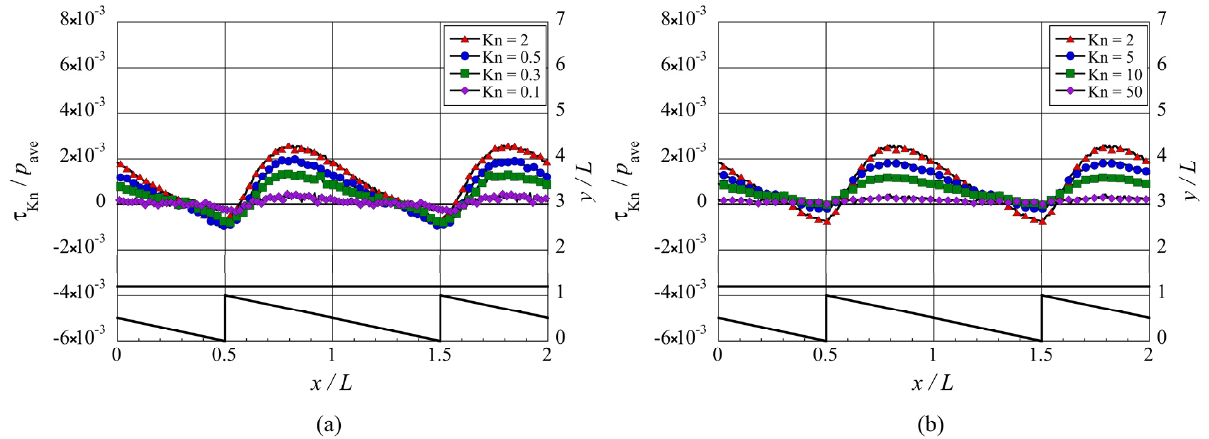
Figure 11. Distributions of the local tangential Knudsen stress, i.e., local propulsive force per unit area, for the ratchet microstructure, at ( a ) selected lower Knudsen numbers, Kn ≤ 2 , and ( b ) selected higher Knudsen numbers, Kn ≥ 2 .